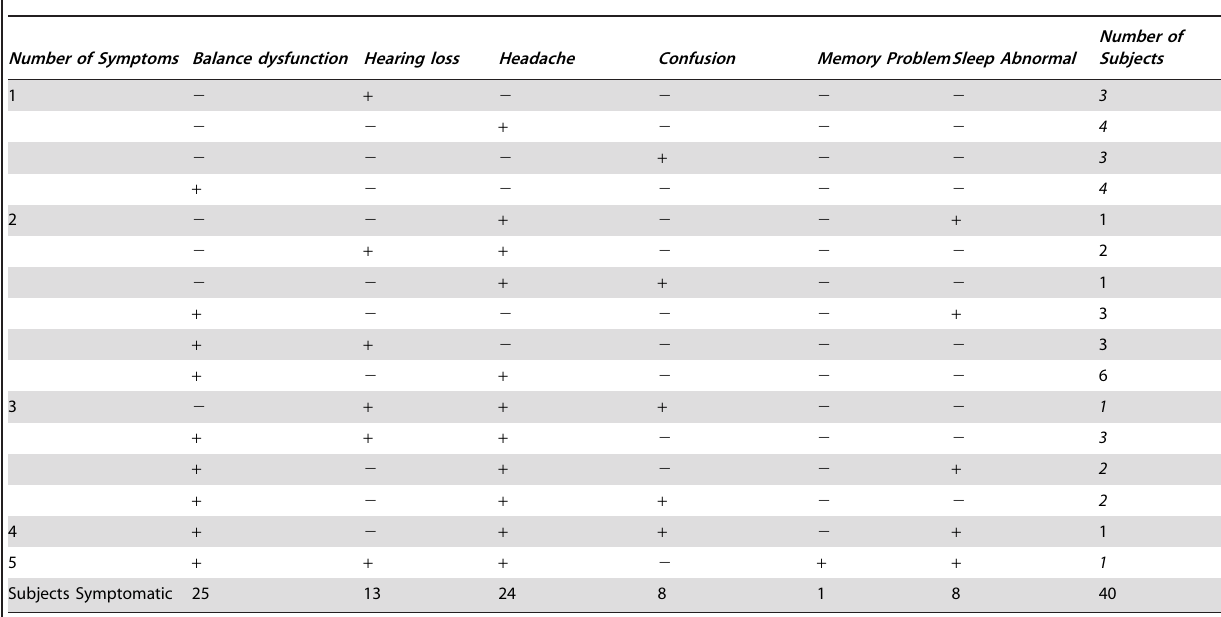
Table 3. Unresolved mTBI Symptom Patterns on Treatment Day 7.